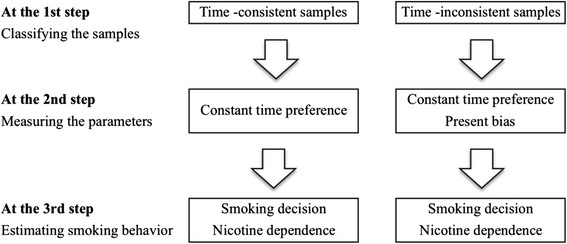
Research strategy.